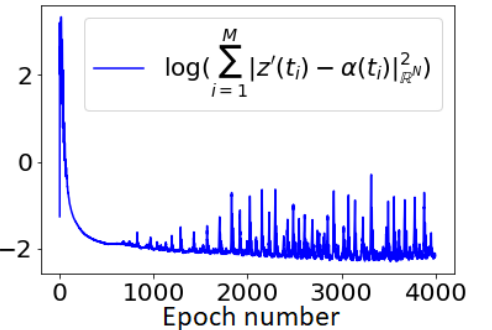
( t )) , with respect to the i h